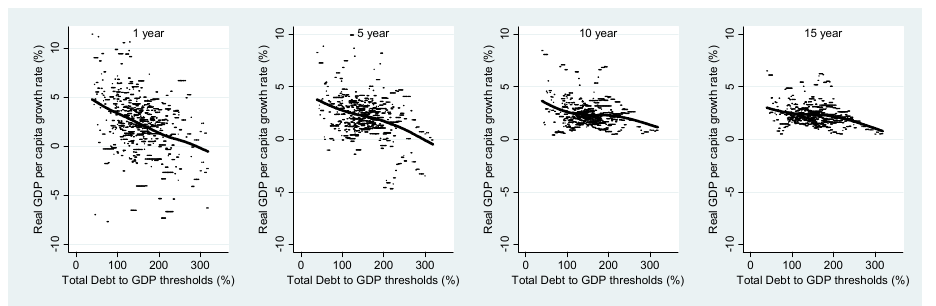
Figure 4 - Total debt and medium- to long-term economic growth (homogenous dataset)